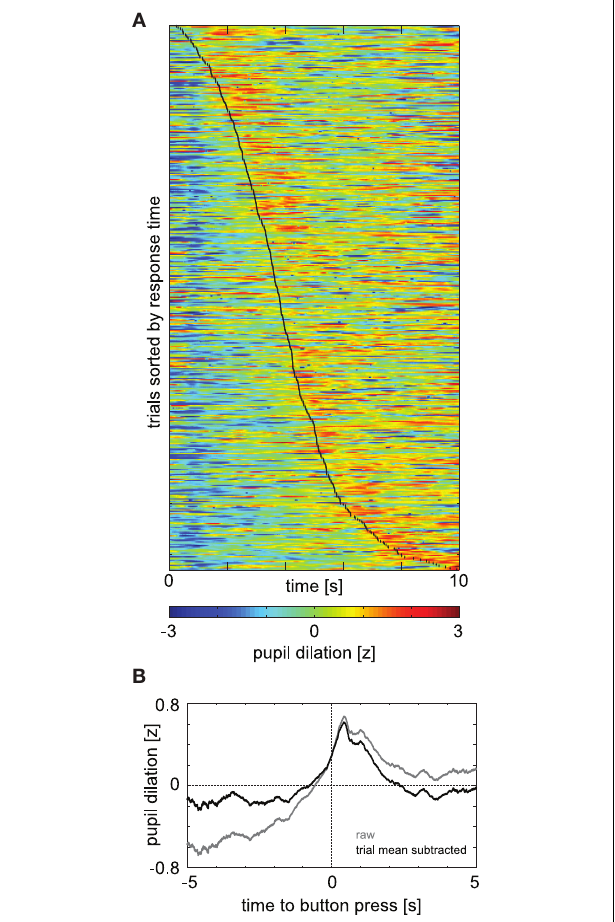
FIGURE 3 | (A) Valid trials of experiment 1 sorted by time of button press (black line) and presented in ascending order (rows); columns denote time since start of the decision period, colors the pupil dilation. For display purposes, pupil diameter was z -normalized within individual trials, but not across trials or subjects. The timing of maximum pupil dilation generally occurring 1–2 s after the button press (red color to the right of the black line), is unaffected by this normalization and thus corresponds to the data used for the main analysis and prediction. (B) Average pupil-dilation in experiment 1 aligned to time of button-press. Gray: raw ( z -score normalized data); black: grand mean subtracted from each trial before aligning and averaging.